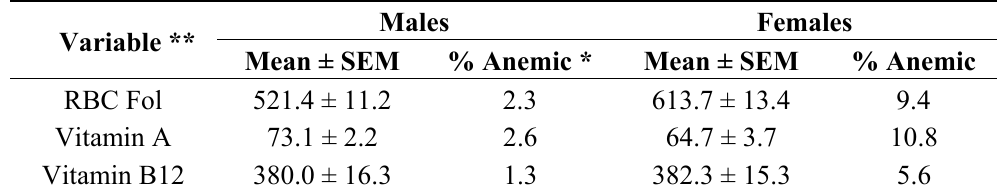
Table 3. Prevalence of percent anemia in Kuwaiti adult males and females with low RBC folate, vitamins A and